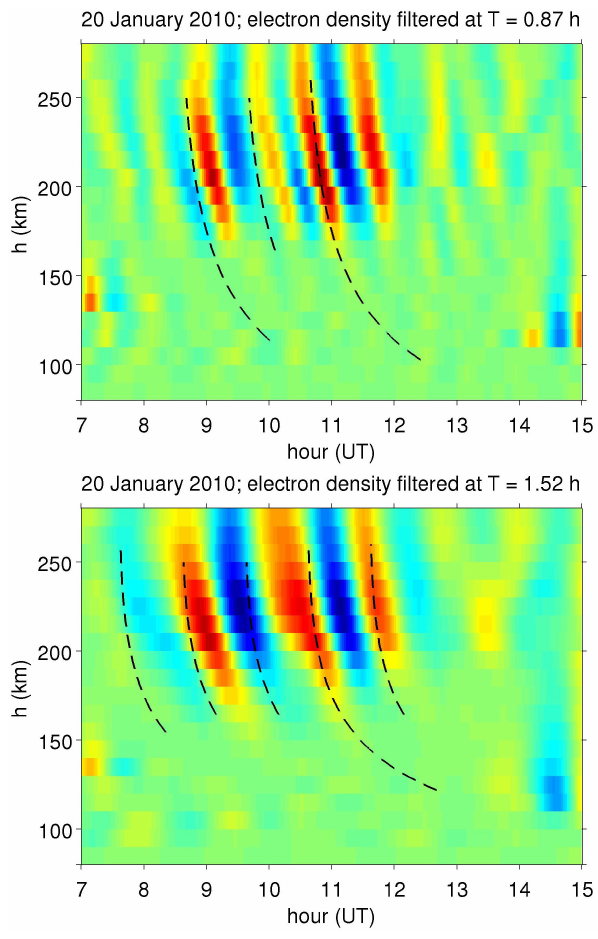
Figure 8. Electron density measured on 20 January 2010, band- pass filtered around 0.87h (upper) and 1.52h (lower), and the wave patterns detected from the